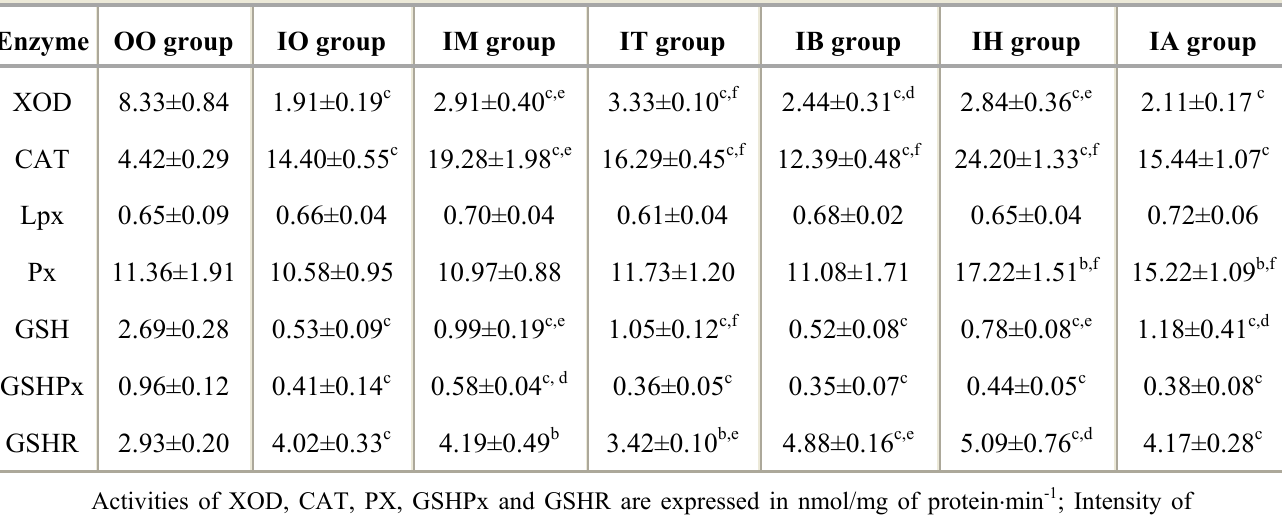
Table 1. Effects of drugs on combined IS and